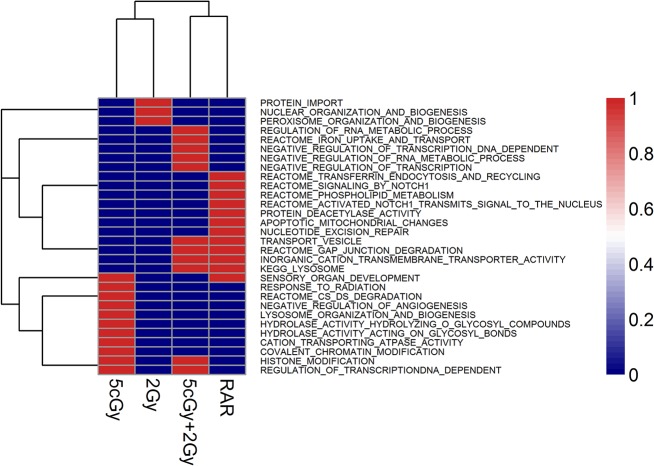
Clustering of GSEA results enriched with positive correlation with increased time profile, for various irradiation groups (viz. 5 cGy, 2 Gy, (5 cGy + 2 Gy) and RAR).The GSEA results were sorted by FDR < 25% or nom p value < 1% thresholds, where appropriate. The heatmap illustrated the gene sets for each irradiation group. The red color codes for the presence of the shown gene sets in a particular group, while the blue color codes for absence of the shown gene sets in a particular group.